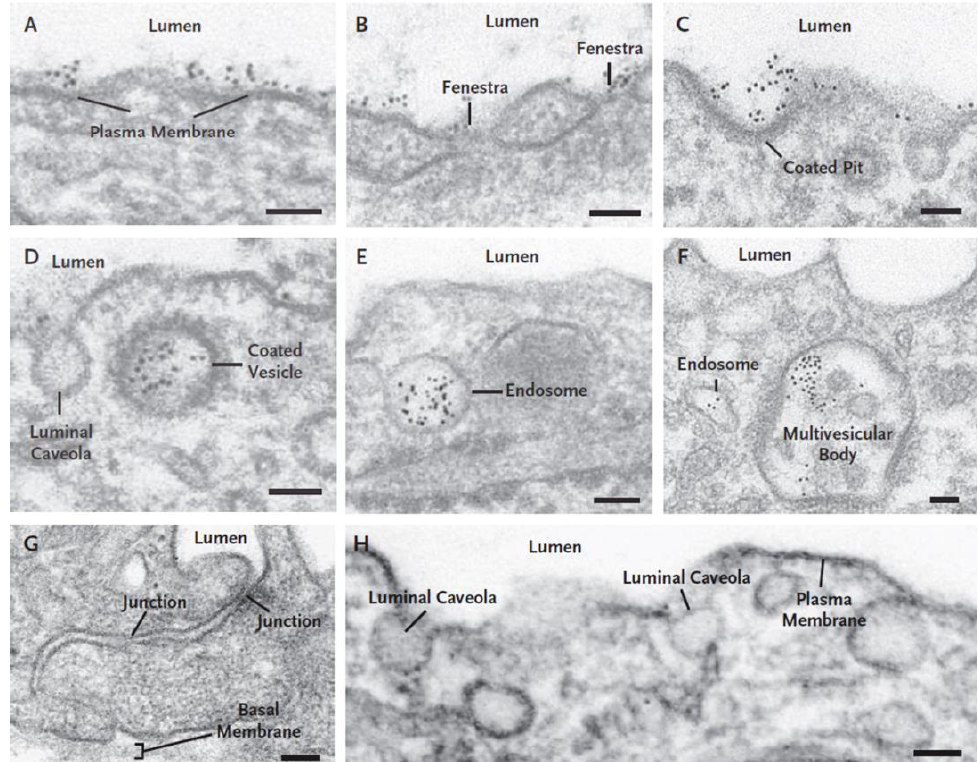
Figure 3. Receptor-mediated mechanism underlying the internalization of mouse monoclonal anti- FSHR antibody coupled to colloidal gold in ECs of tumor blood vessels associated with tumors generated by the prostate cancer line LNCaP in nude mice. After 20 min of perfusion of FSHR-Au5 nm the tracer was bound to the plasma membrane ( A ), to diaphragms of fenestrae ( B ), to luminal clathrin-coated pits ( C ), and internalized in clathrin-coated pits ( D ), early endosomes ( E ), and multivesicular bodies ( F ). No tracer was internalized in the caveolae open to the lumen of the tumor blood vessel ( C , D ). No tracer particles crossed the endothelial barrier through the junctions ( G ). No tracer particles were seen associated with the microvascular ECs in the normal lung ( H ). Scale bars represent 50 nm in panels A – F and H, and 100 nm in panel G. Reprinted with permission from ref. [94]. Copyright 2010 Massachusetts Medical Society.